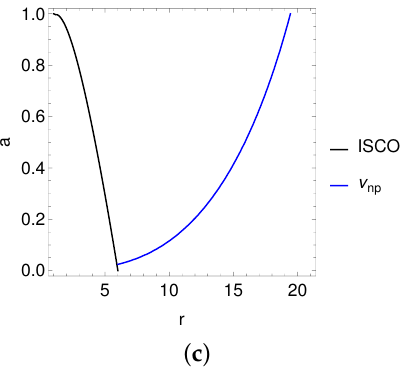
Figure 3. The figure shows the circular orbit frequency contours of ( a ) ν φ , Equation (7a), for the QPO frequencies of RE J1034 + 396, MS 2254.9-3712, Mrk 766, and MCG-06-30-15, given in Table 2; ( b ) ν φ and ν pp contours, Equation (7b), for two QPO frequencies of Mrk 766; and ( c ) ν np contour, Equation (7c), for the QPO frequency of 2XMM J123103.2+110648.